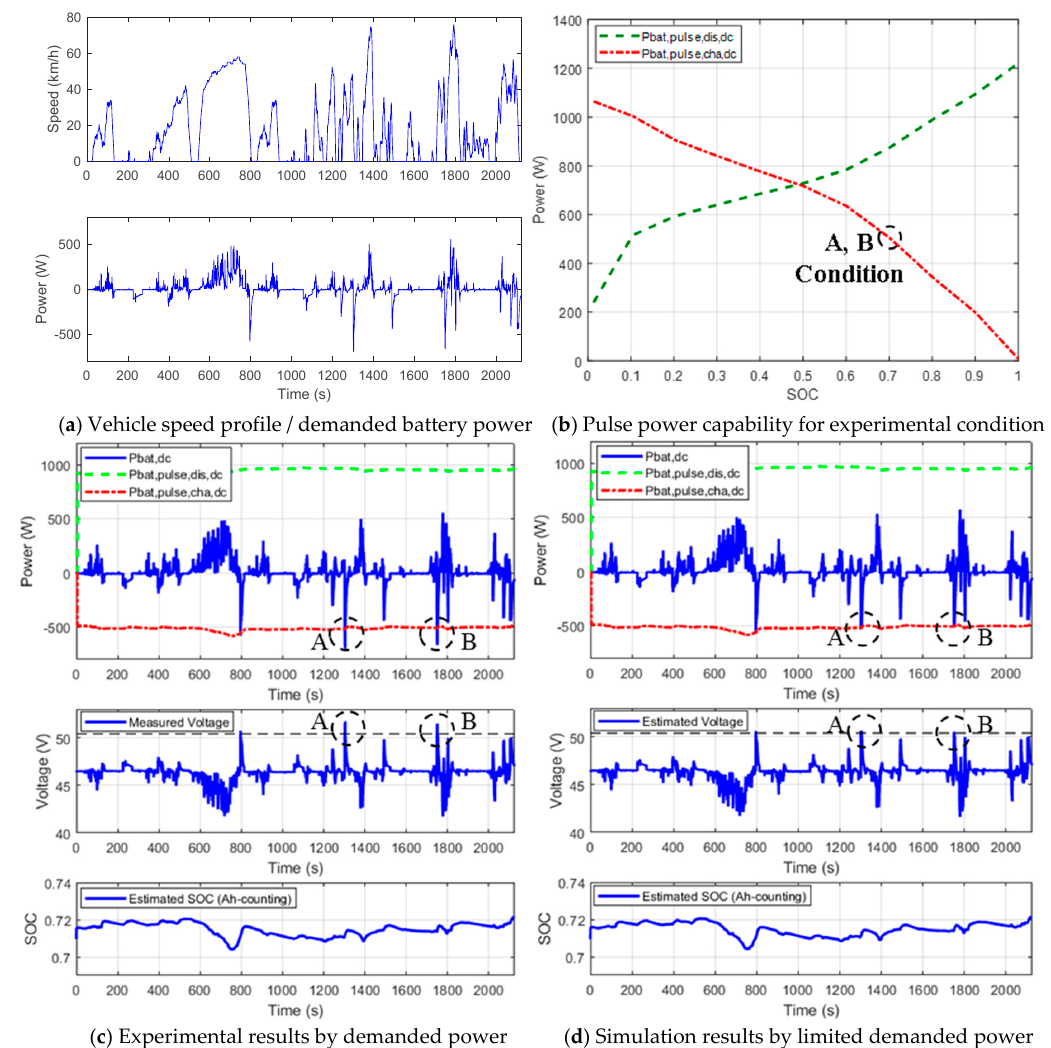
Figure 12. Battery charging and discharging result by a scaled-down power profile of the electric vehicle.